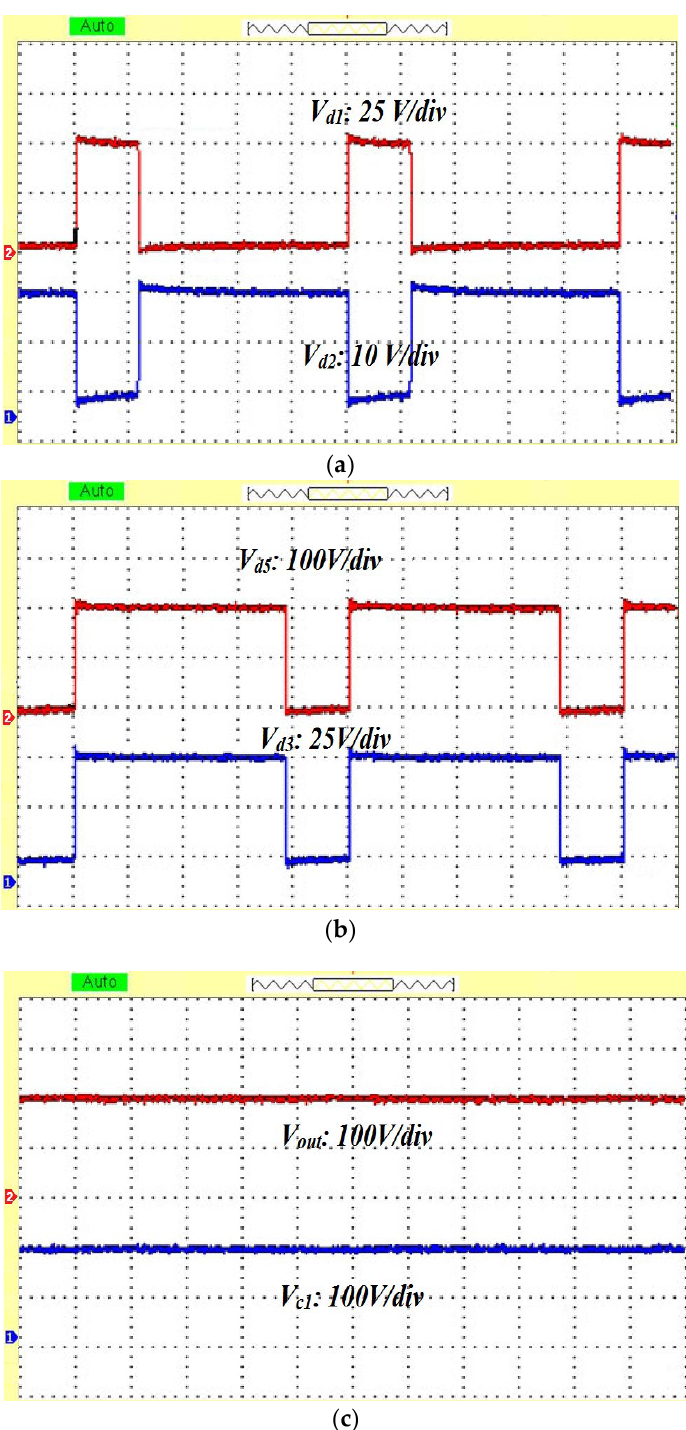
Figure 11. Various waveforms: ( a ) V d1 and V d2 ; ( b ) V d3 and V d5 ; ( c ) V c1 and V out .